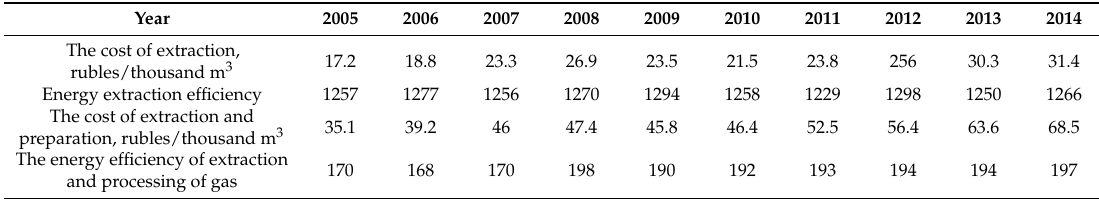
Table 5. Dynamics of the indicators of unit costs and energy